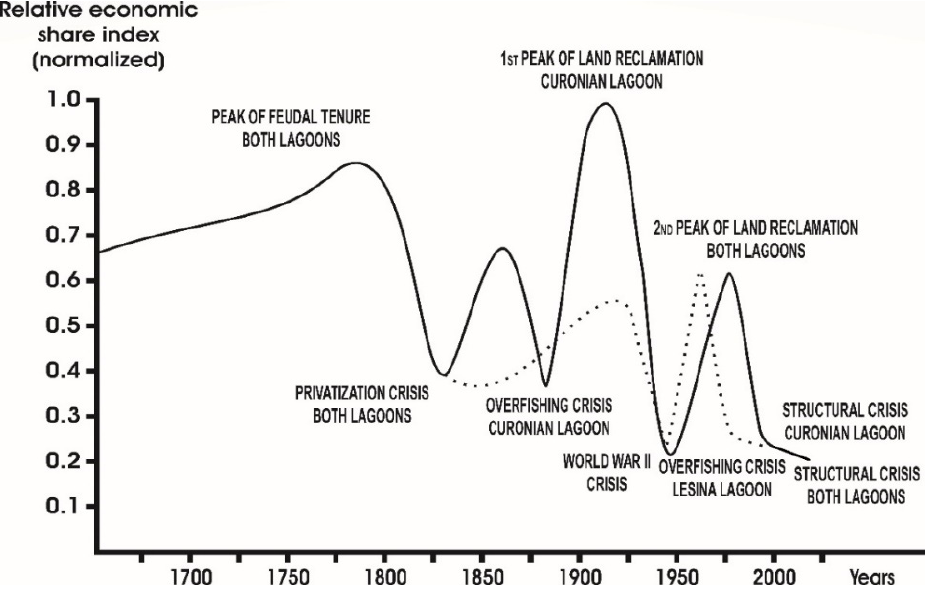
Figure 5. Resulting relative economic share of yielded products from lagoon areas on a regional scale (taking the first peak of land reclamation for 1.0; the dashed line shows the relative share of the products from Lesina Lagoon if it differs from the Curonian Lagoon) (Compiled and plotted by Ram ū nas Povilanskas)